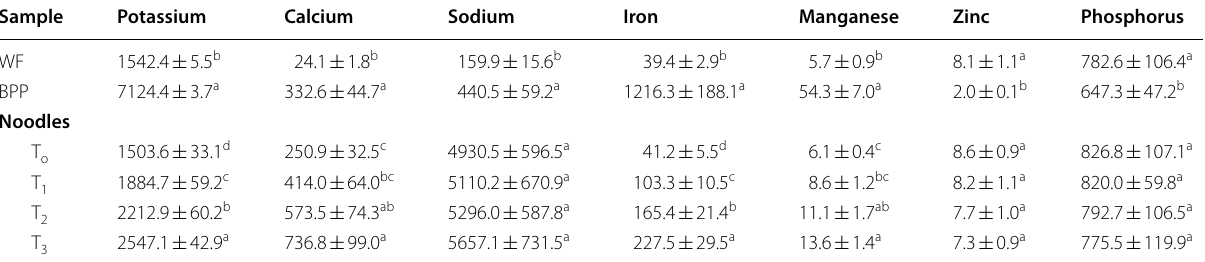
Values are means of triplicates HSD-Tukey Test